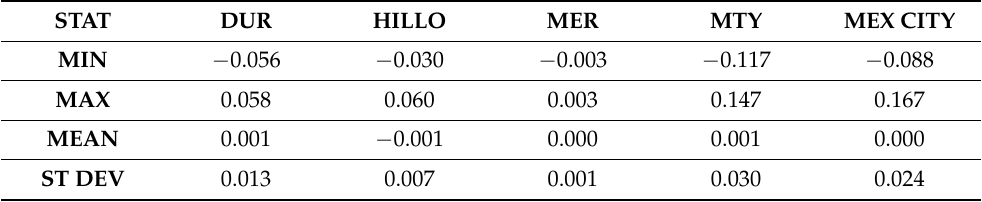
Figure 3. Surface plots of the topographic mass contribution dN to geoid undulations for five Mexican urban areas: ( a ) Durango, ( b ) Hermosillo, ( c ) Merida, ( d ) Mexico City, ( e ) Monterrey. Discretization method: spherical tesseroids. Integration method 2D spherical integration with 1D-FFT. Units: Meters. Table 2. Statistics of topographic mass contributions to the geoid for 5 Mexican urban areas. Dis- cretization method: spherical tesseroids. Integration method 2D spherical integration with 1D-FFT. Units: